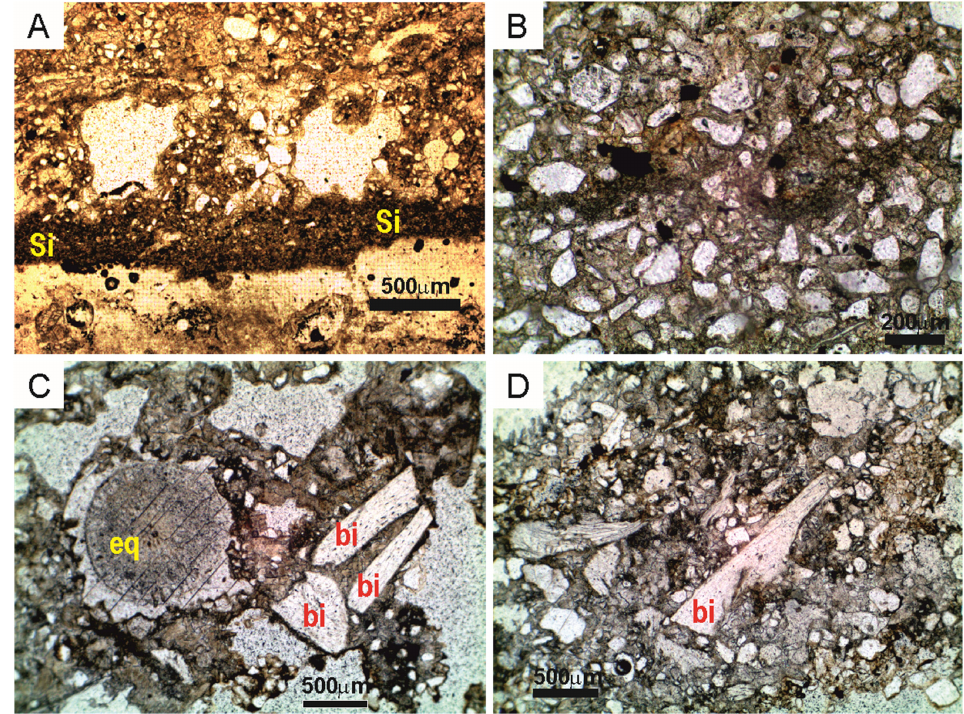
Figure 7. Microphotographs of feature characteristics of calcite crusts with abundant siliciclastic grains: ( A ) thin silty micritic crust (Si) on bone surface; a net contact with the overlying sandy and more porous crust can be observed (Sample 280). ( B ) Detail of sandy crust with a high proportion of subangular quartz grains in a micrite matrix (Sample 709). ( C ) Bioclast (echinoderm) (eq) and bone fragments (bi) in sandy micritic crust (Sample 324). ( D ) Bone fragments (bi) in sandy micritic crust (Sample 324). All microphotographs were taken under plane-polarized light.